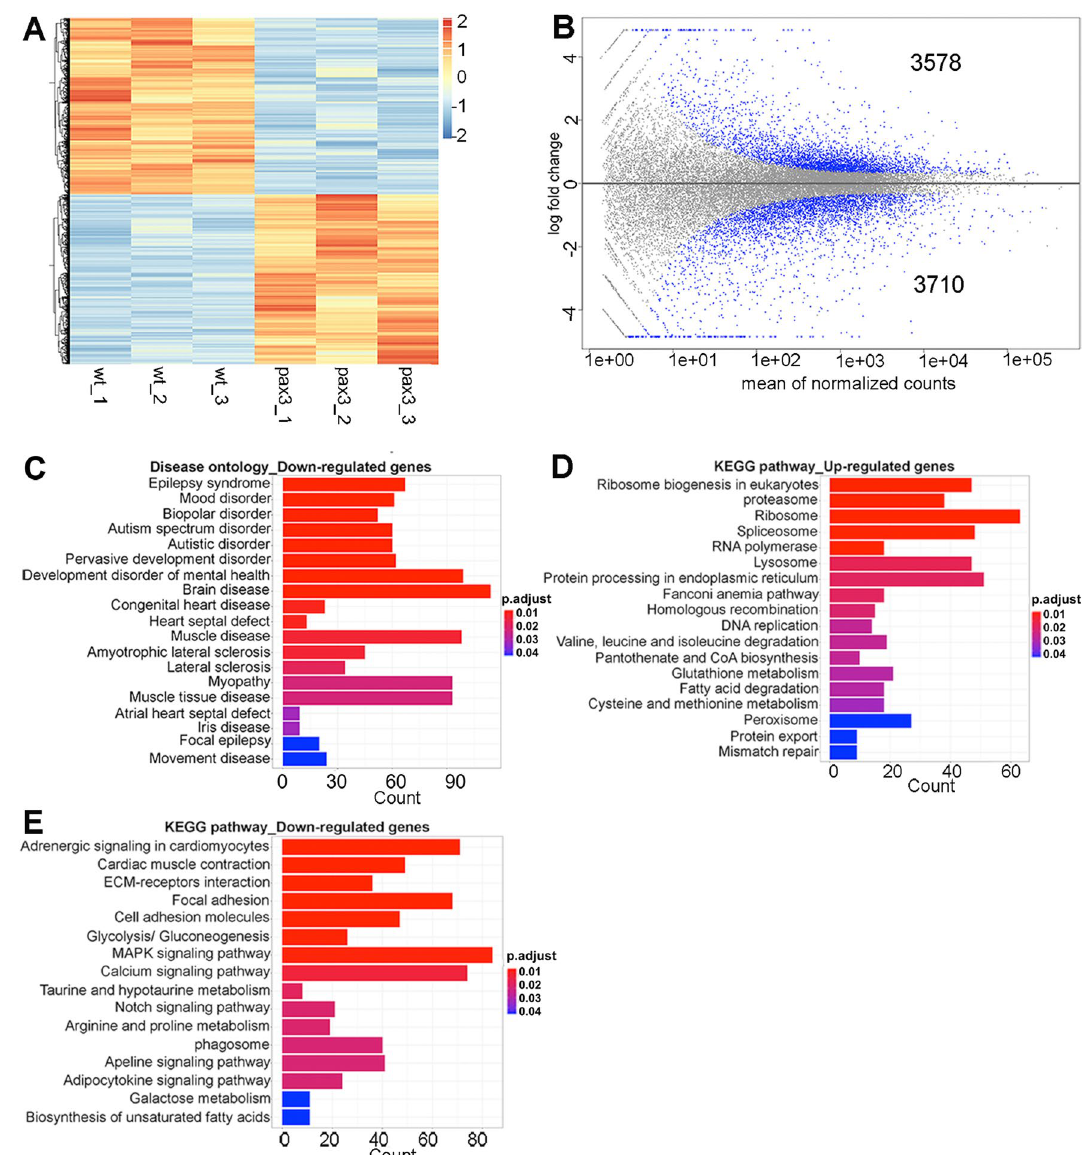
Figure 1. Clustering and pathway analysis of differentially expressed genes (DEGs). (A) Heatmap of significant DEGs between wild type and pax3a −/− ;pax3b −/− zebrafish embryos. Regularized log transformed (rlog) count matrix was generated using DESeq2 package. Significant DEGs were used to plot the heatmap of rlog counts. Red and blue represent up- and down-regulated genes, respectively. (B) Scatter plot for DEGs in wild type and pax3a −/− ;pax3b −/− showing mean of normalized counts and log2 fold change. All differentially expressed genes (in blue) with adjusted p-value < 0.01. (C) Disease ontology analysis of down-regulated genes. (D,E) KEGG pathway analysis of up- and down-regulated genes. Bar plots represents the number of DEGs involved in each condition. Adjusted p-value was represented by colour scale, and the statistically significance level decreased from red (highly significant) to blue (relatively lower significant). p-value <